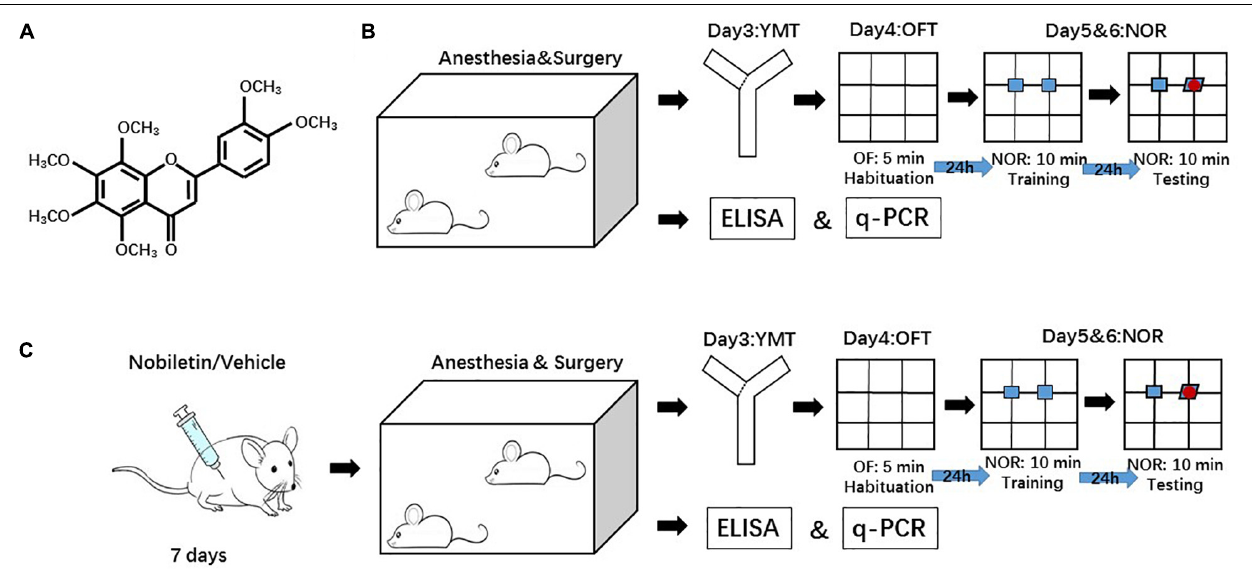
FIGURE 1 | Diagram of the experimental design. (A) The structure of Nobiletin (NOB). (B) The mice received YMT at postoperative day 3, OFT at postoperative day 4 and NOR at postoperative day 5 and 6. (C) Another group of mice received NOB i.p. for 7 consecutive days before surgery. The behavioral tests were studies with the same interval as in panel (B) . YMT: Y maze test. OFT: open filed test. NOR: novel object